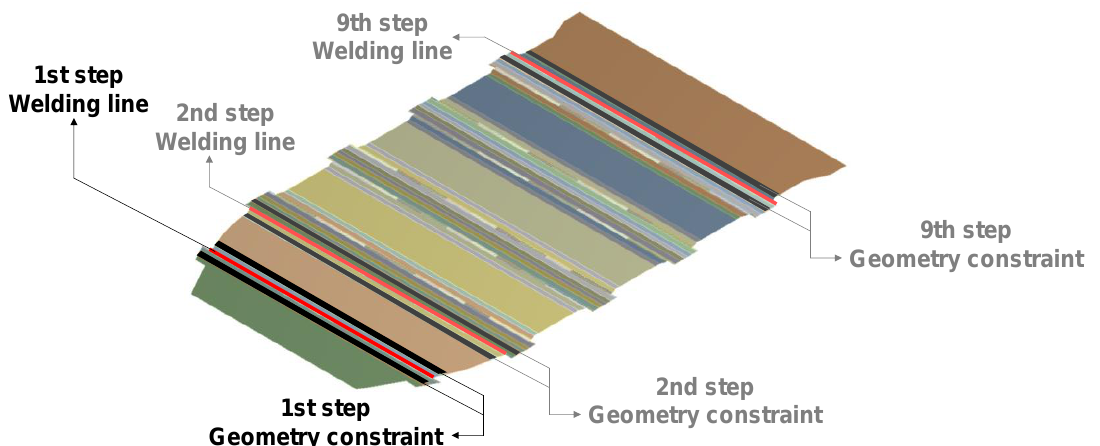
Figure 16. Geometric boundary conditions of the aluminum battery housing model.